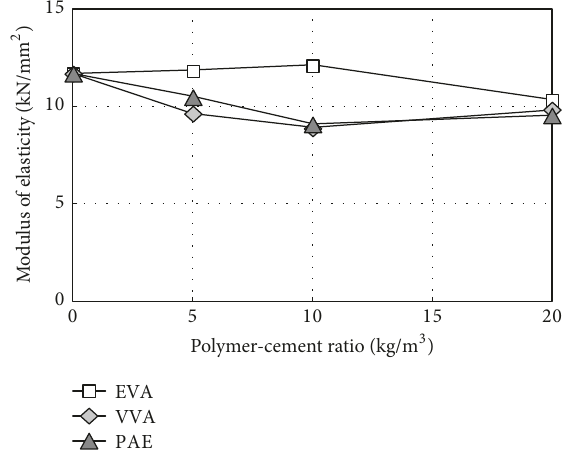
Figure 12: Modulus of elasticity of PCM with various polymers at room